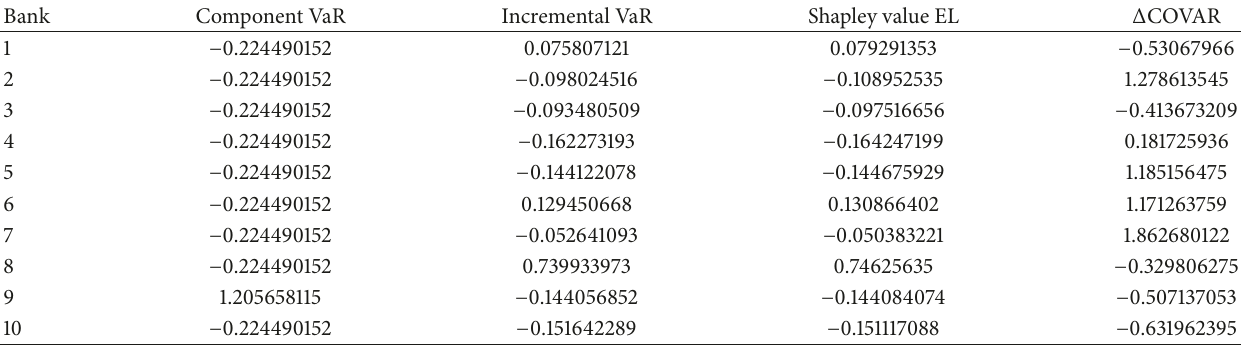
Table 1: Increase in capital as a share of banks’ risk weighted assets for macroprudential capital allocation mechanism in 2008. Bank